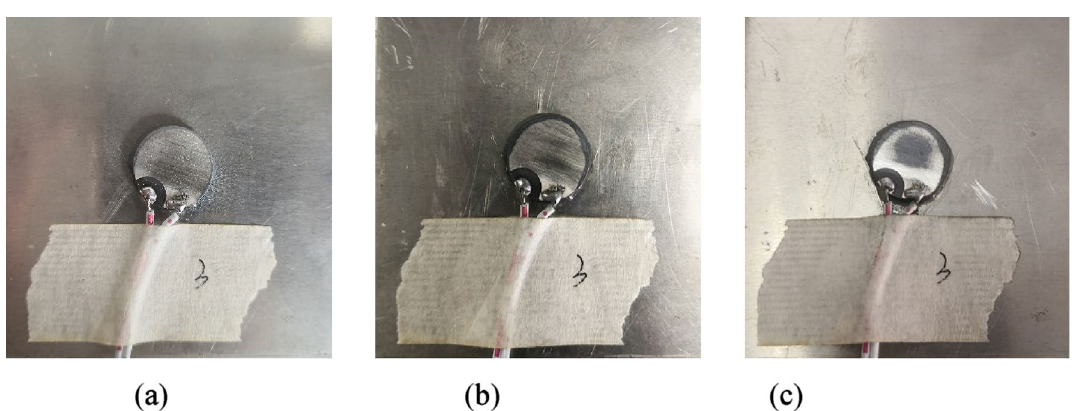
Figure 6. Wear of 3# PZT: ( a ) mild wear; ( b ) moderate wear; ( c ) severe wear.